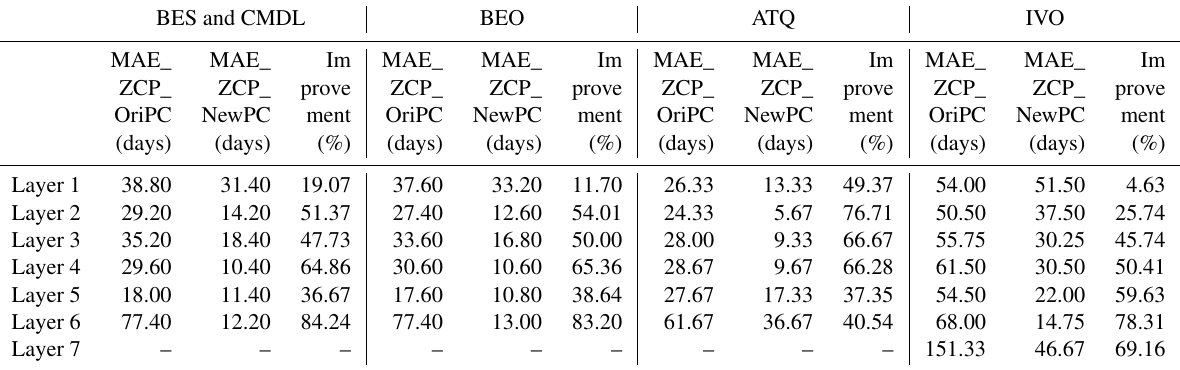
Table 3. Mean absolute error (MAE) of simulated ZCP (days) with the original phase-change scheme (Ori_PC) and newly resized phase- change scheme (NewPC), and the relative improvement (%) of using the new phase-change scheme compared to the baseline results,